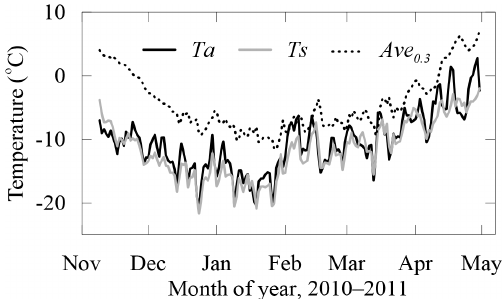
Figure 10. Daily means of the observed air temperature ( T a ), the averaged ice/water temperature of the top 30cm (Ave 0 − 0 . 3 ), and the calculated ice surface temperature ( T s